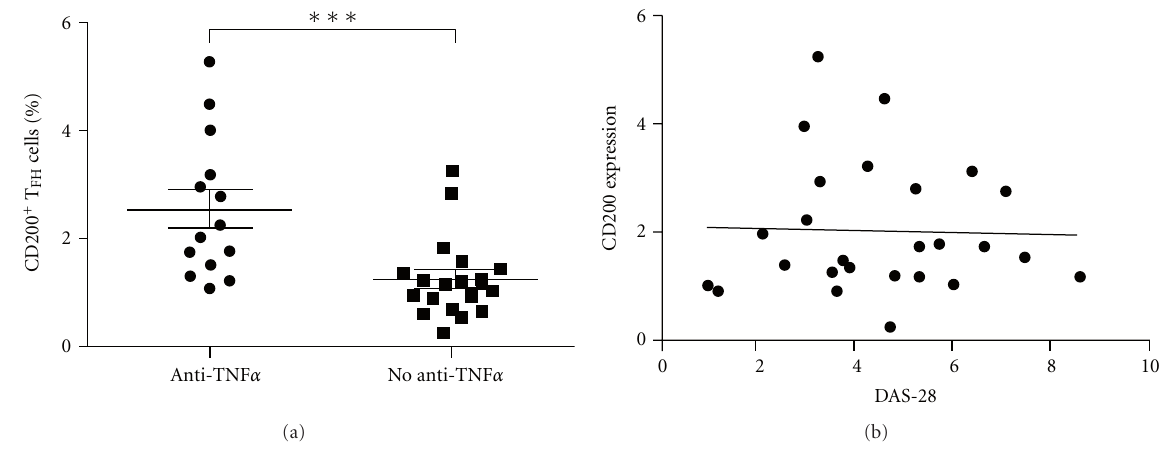
Figure 4: Relationship between CD200 expression on T FH cells, treatment, and disease activity. (a) The % of T FH cells expressing CD200 in patients being treated with anti-TNF α therapy was significantly increased compared with patients not on anti-TNF α therapy ( P = 0 . 0008). The mean DAS of patients receiving anti-TNF α therapy was 4.679, compared with 4.418 in patients who were not ( P = 0 . 875). Each spot represents an individual patient, and the mean ± SEM are shown. (b) Correlation between T FH cell CD200 expression and DAS-28 score ( r 2 = 0 . 0009, P = 0 .